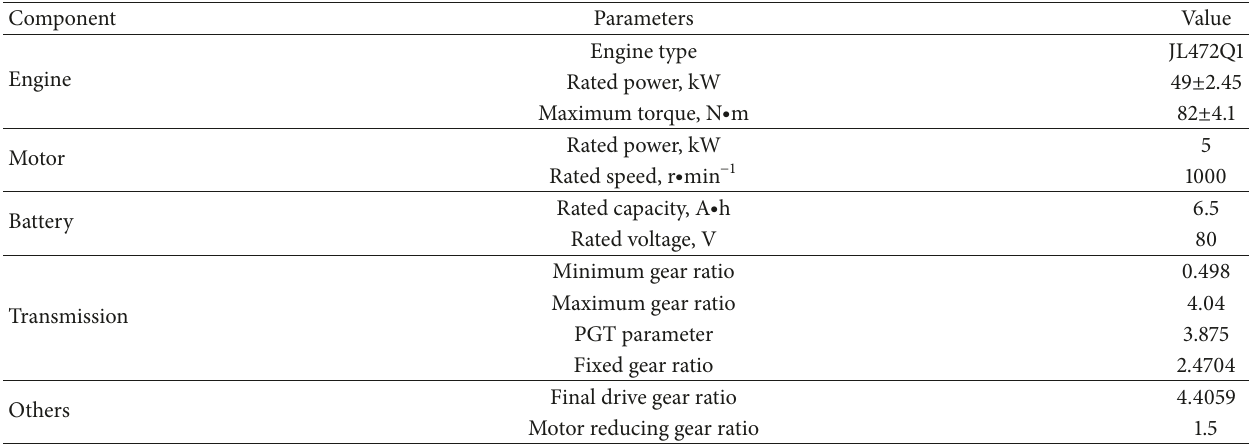
Table 1: Super-mild HEV